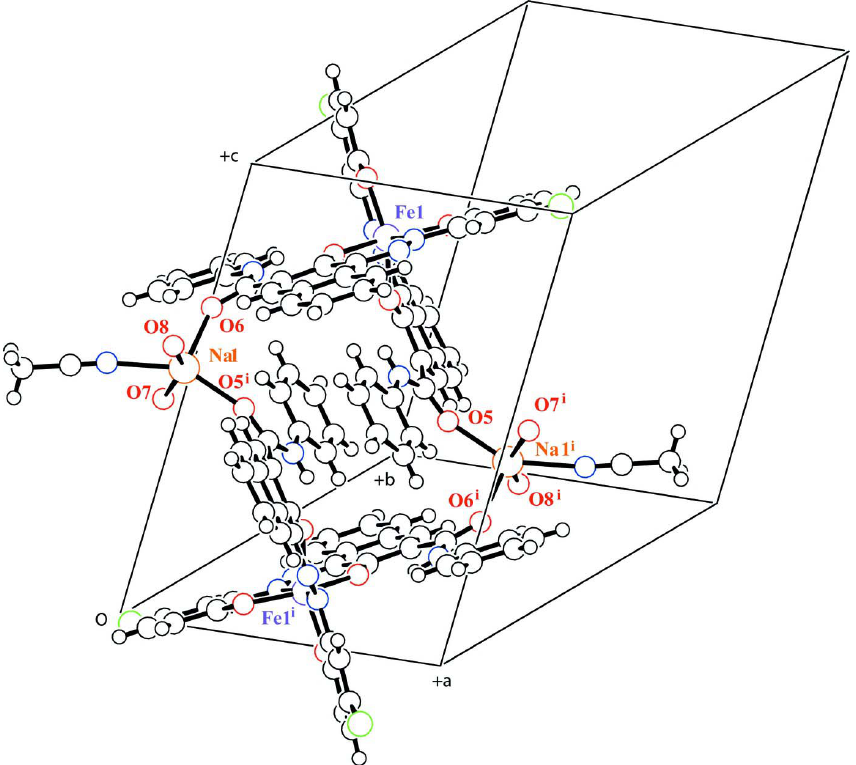
Figure 2 The centrosymmetric complex dimer. The two Fe-azo complexes are bridged by Na1 and Na1 i cations through Na1—O5 i and Na1—O6, and Na1 i —O5 and Na1 i —O6 i bonds, respectively [symmetry code(i): 1 - x , - y , 1 - z ].